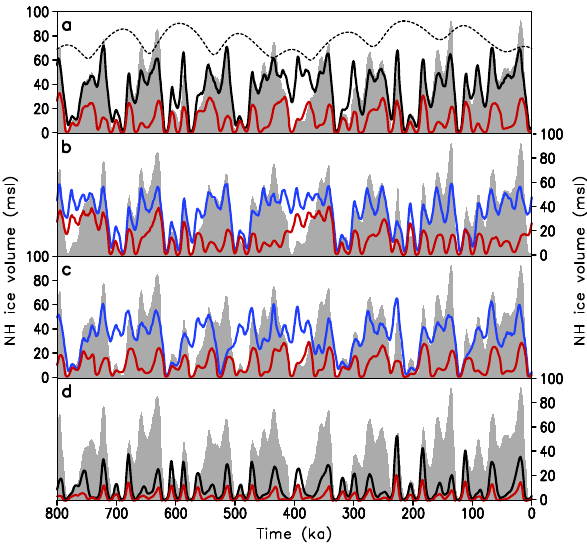
Fig. 5. Simulated ice volume variations in a subset of the exper- iments with constant CO 2 (colored lines) versus the Baseline ex- periment (grey shading). (a) CC n experiments, (b) COB n exper- iments (constant obliquity), (c) CEC n /0.02 experiments (constant eccentricity equal to 0.02), (d) REG n experiments (with continents completely covered by thick sediment layer). Black lines corre- spond to a CO 2 concentration of 200ppm, blue – 220ppm and red – 280ppm. Dashed line at the top shows eccentricity.